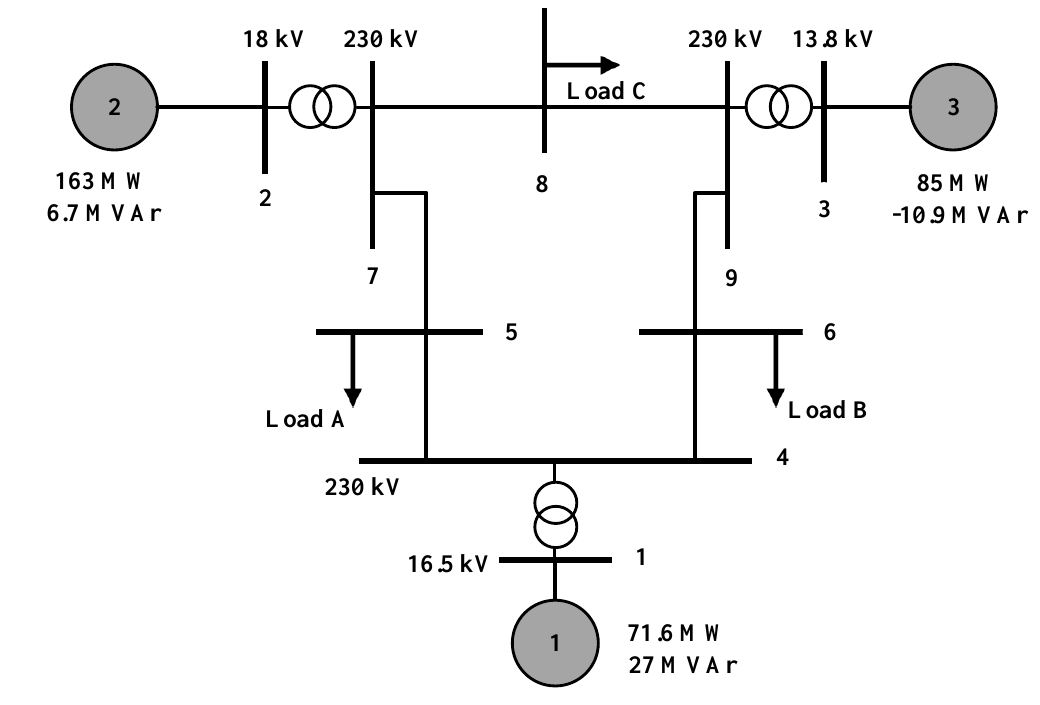
Figure A1. Nine (9) bus system network model.